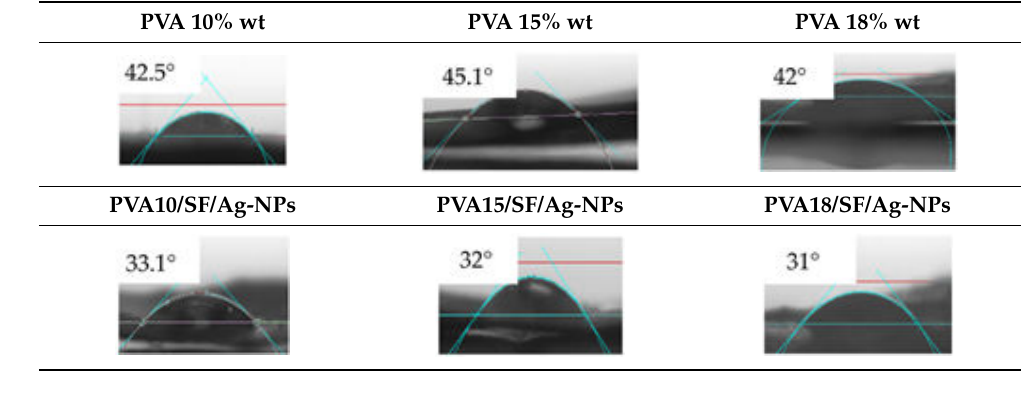
Figure 8. ATR-FTIR spectra of PVA pristine and PVA/SF/Ag-NPs composite scaffolds. In this study, the WCA of PVA 10% wt, 15% wt, and 18% wt pristine scaffolds were 42.5 ◦ , 45.1 ◦ , and 42 ◦ , respectively, similar to the previously reported 42 ◦ [7] and 41.16 ◦ [9]. The WCA of PVA composite scaffolds decreased with the incorporation of fibroin and silver nanoparticles to PVA10/SF/Ag-NPs at 31.1 ◦ , PVA15/SF/Ag-NPs at 32 ◦ , and PVA18/SF/Ag-NPs at 31 ◦ . The PVA concentration had no influence on the hydrophilic characteristics, as shown in Table 2. Table 2. Water contact angle of pristine PVA scaffolds and PVA/fibroin/Ag-NPs